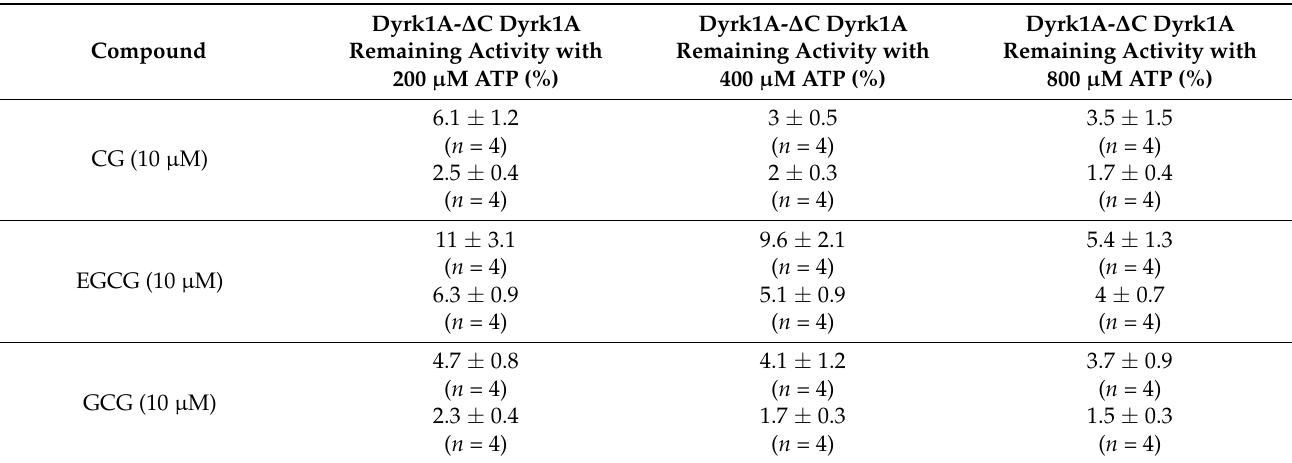
Table 2. Analysis of the inhibition of Dyrk1A- ∆ C activity by CG, EGCG and GCG as a function of ATP